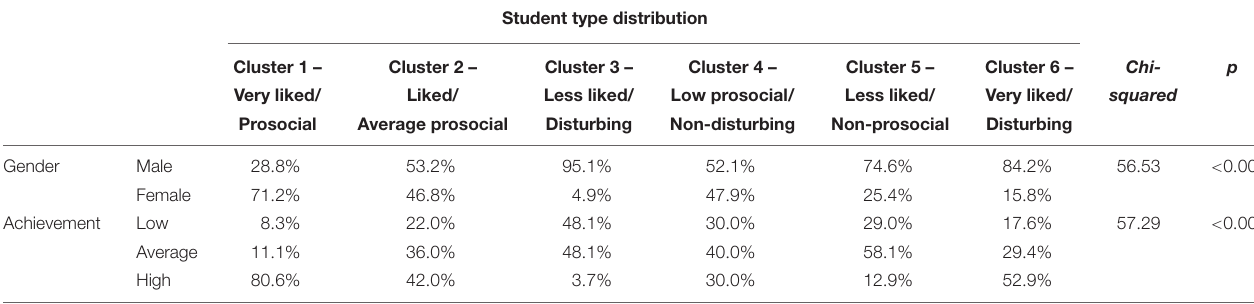
TABLE 2 | Clusters by gender and academic achievement.